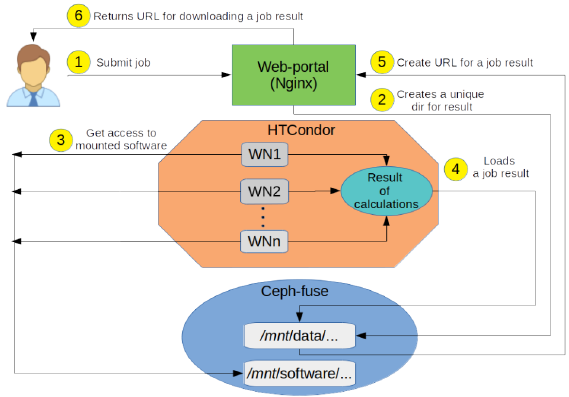
Figure 3. The schema of the data storage system of the JINR SaaS